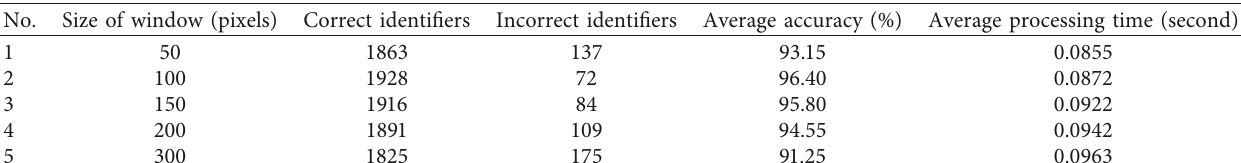
Table 6: Results of lane detection for different size of window with the TuSimple dataset.